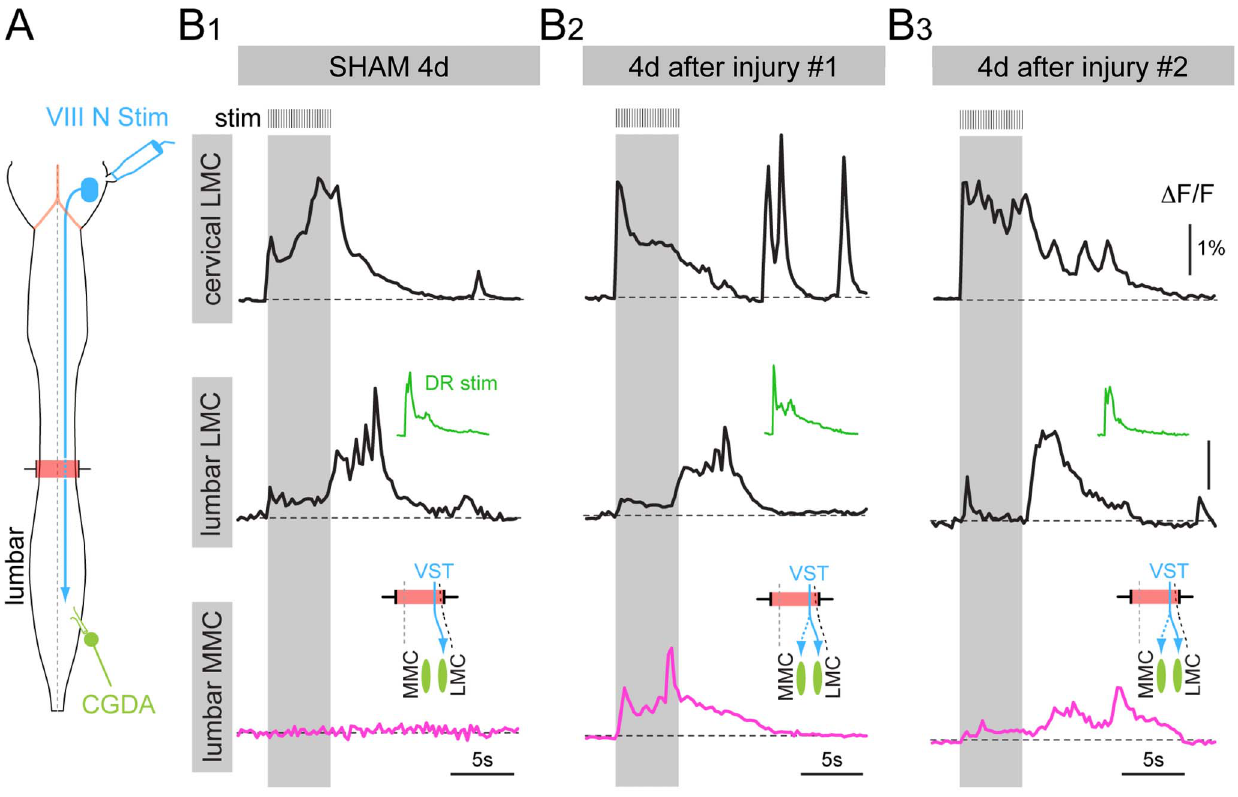
Figure 8. Reorganization of vestibulospinal connections to lumbar medial and lateral motor columns following SCC. (A) Schematic of the ex vivo preparation of the brain stem and spinal cord showing the site of vestibular nerve stimulation (VIII N Stim) and the CGDA labeling of the L5 ventral root. (B) Low temporal resolution (4 Hz frame rate) optical recordings of calcium transients elicited in LMC MNs (black traces) and MMC MNs (red traces) in response to train stimulation of the vestibular nerve (same parameters as in Fig. 6) in one sham control mouse (B1) and two SCC mice (B2, B3) 4 days after surgery/injury. D F/F represents fluorescence change in % relative to baseline. The small green traces (DR stim) show responses to stimulation of the L5 dorsal root. Insets above the MMC traces show the apparent reorganized synaptic connectivity from lateral vestibulospinal tract (VST) to LMC and MMC. (Fig. 6B1, red trace), but no discharge in lumbar roots (Fig. 6B2, red trace). By 4 days post-injury (n =4), the lumbar root discharge had partially recovered (Fig. 6C2, red trace), but was delayed and less intense than in sham controls (Fig. 6C2, black trace).